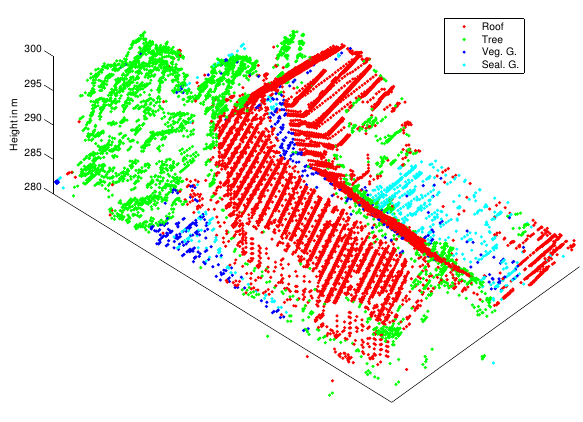
Figure 6: Gable roof and adjacent trees, generally well labelled solely according to geometric shape distribution features.